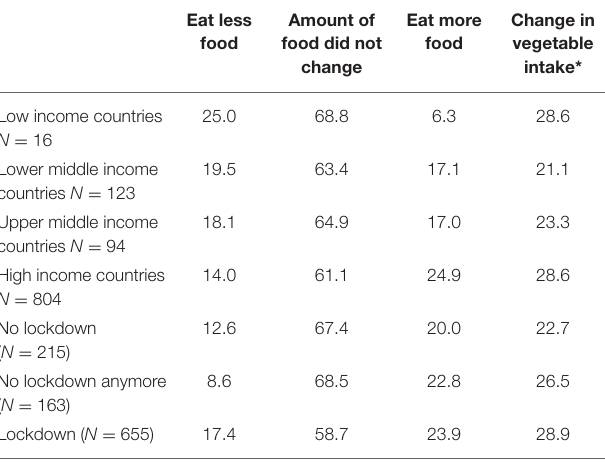
TABLE 2 | Perceived change in food quantity in relation to lockdown scenarios indicated in percent in reference to prior to the pandemic.